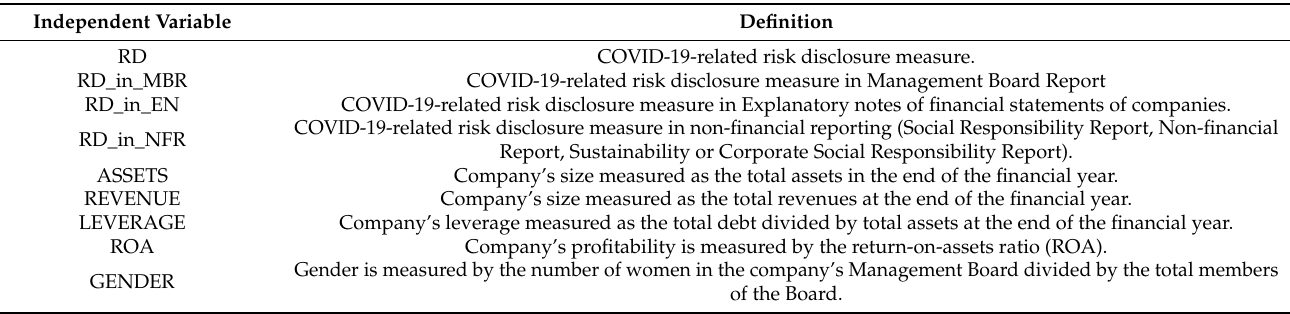
Table 1. Variables and Their